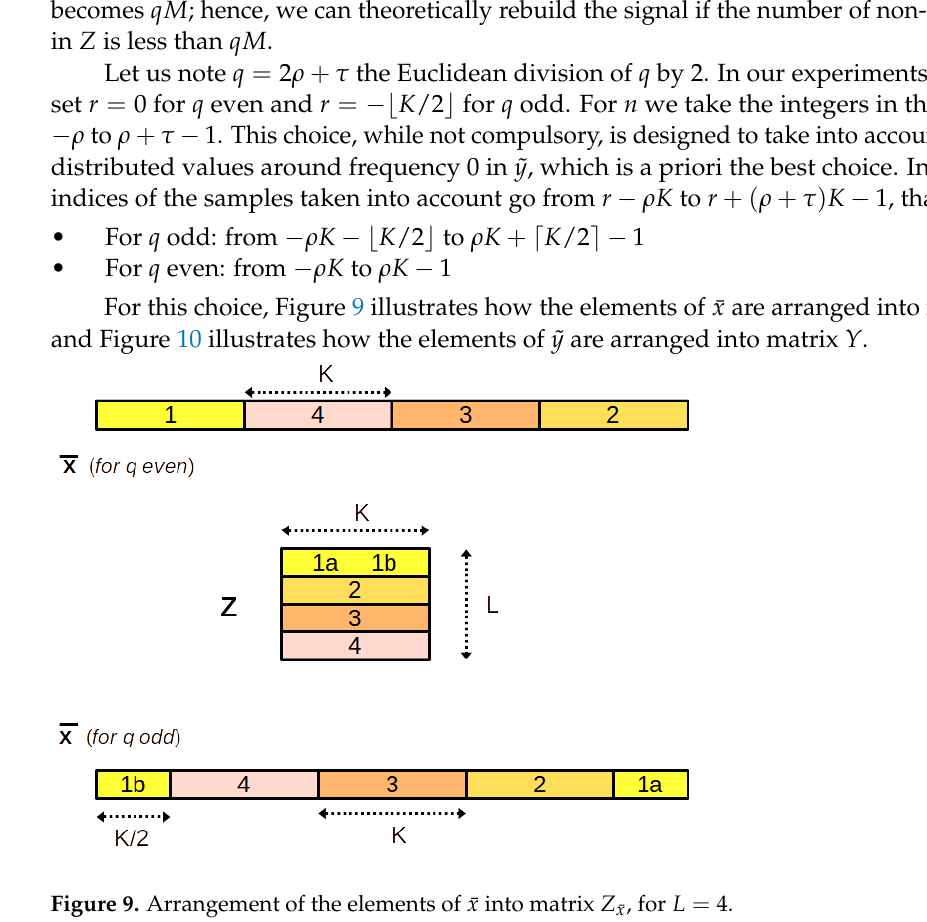
Figure 9. Arrangement of the elements of ¯ x into matrix Z ¯ x , for L = 4.